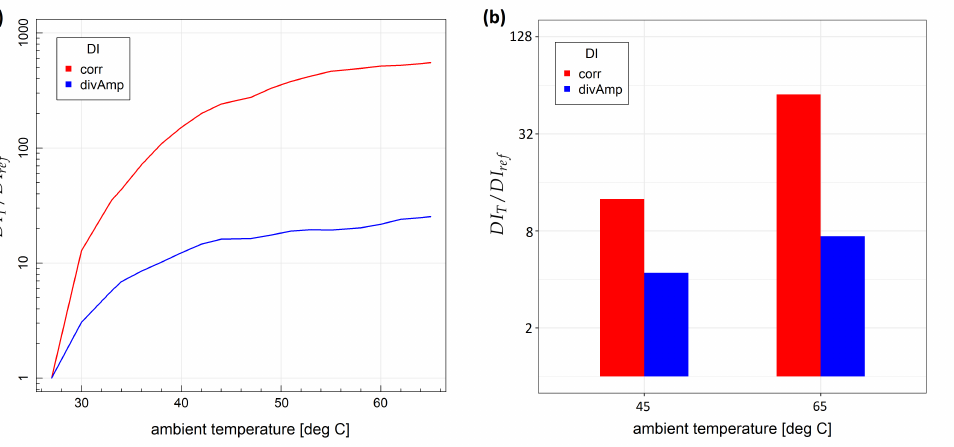
Figure 6. Variability of damage indices with respect to temperature change: ( a ) specimen no. 1; ( b ) specimen no. 2.